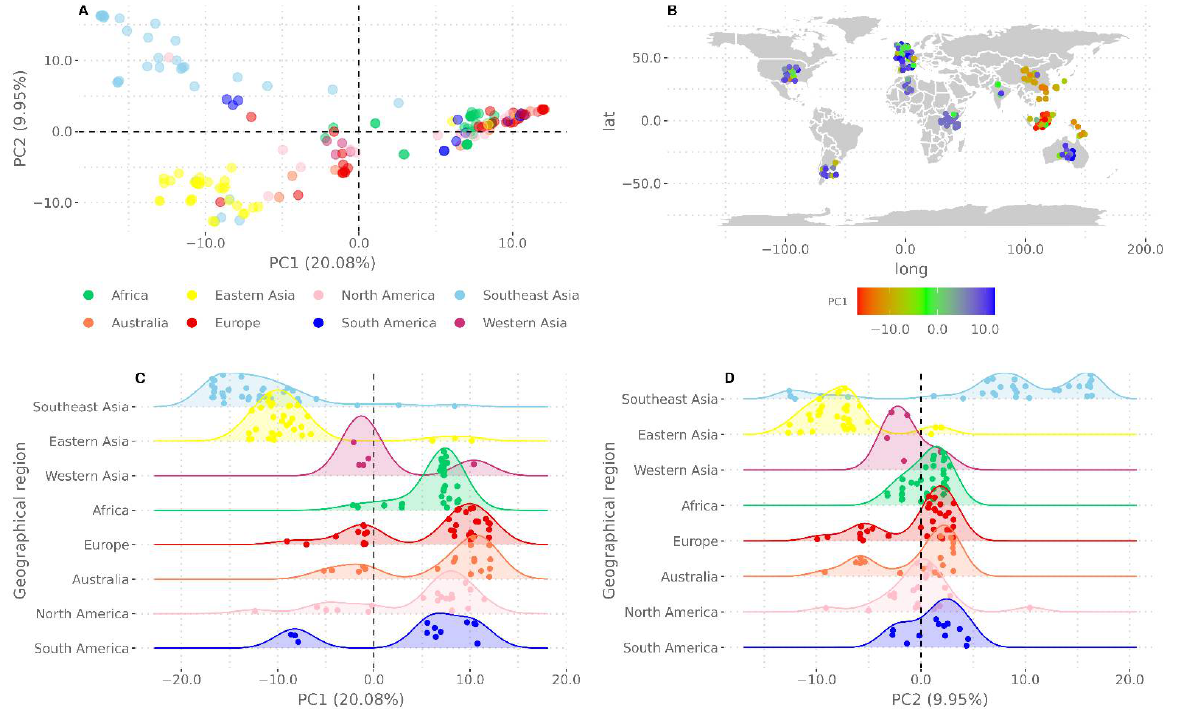
Figure 4. Principal component analysis: ( A ) PCA of EBV1 sequences showing PC1 and PC2, whereby sequences are colored according to their geographic origin; ( B ) geographical distribution of the sequences, whereby the color intensity in the heat map scale represents the segregation potential of PC1; ( C , D ) quantification of the differences in PCA distribution ( C ) for PC1 and ( D ) for PC2.